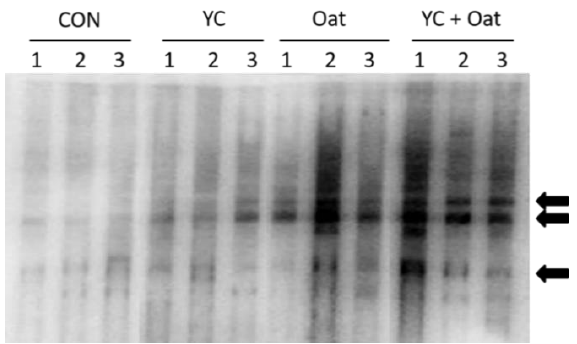
Figure 3. Milk IgG Reactivity. The E. coli specific reactivity of milk IgG was determined after prob- ing resolved and immobilized E. coli extracts with milk collected from sows ( n = 3) in each diet group: control (CON), yeast culture (YC), and Oat. Arrows indicate major reactivity with E. coli antigens.